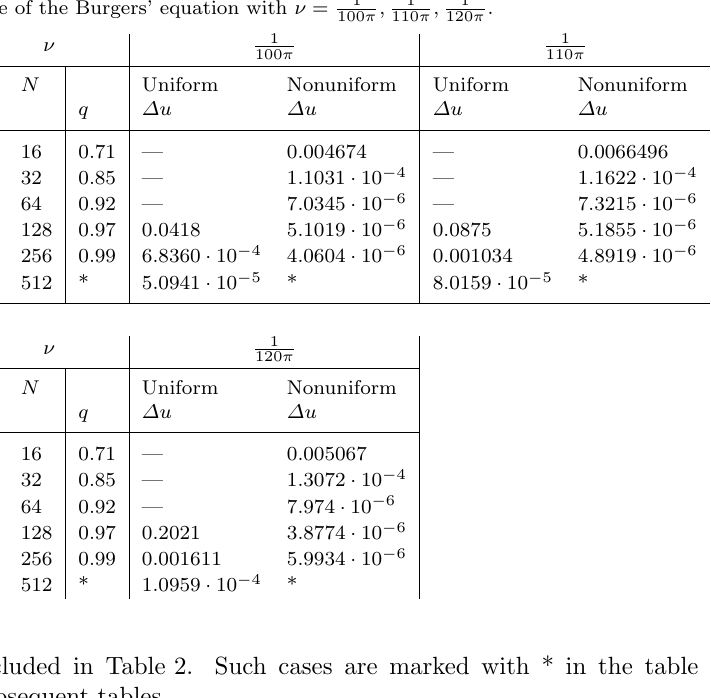
, 1 , 1 . 100 π 110 π 120 π 1 100 π 110